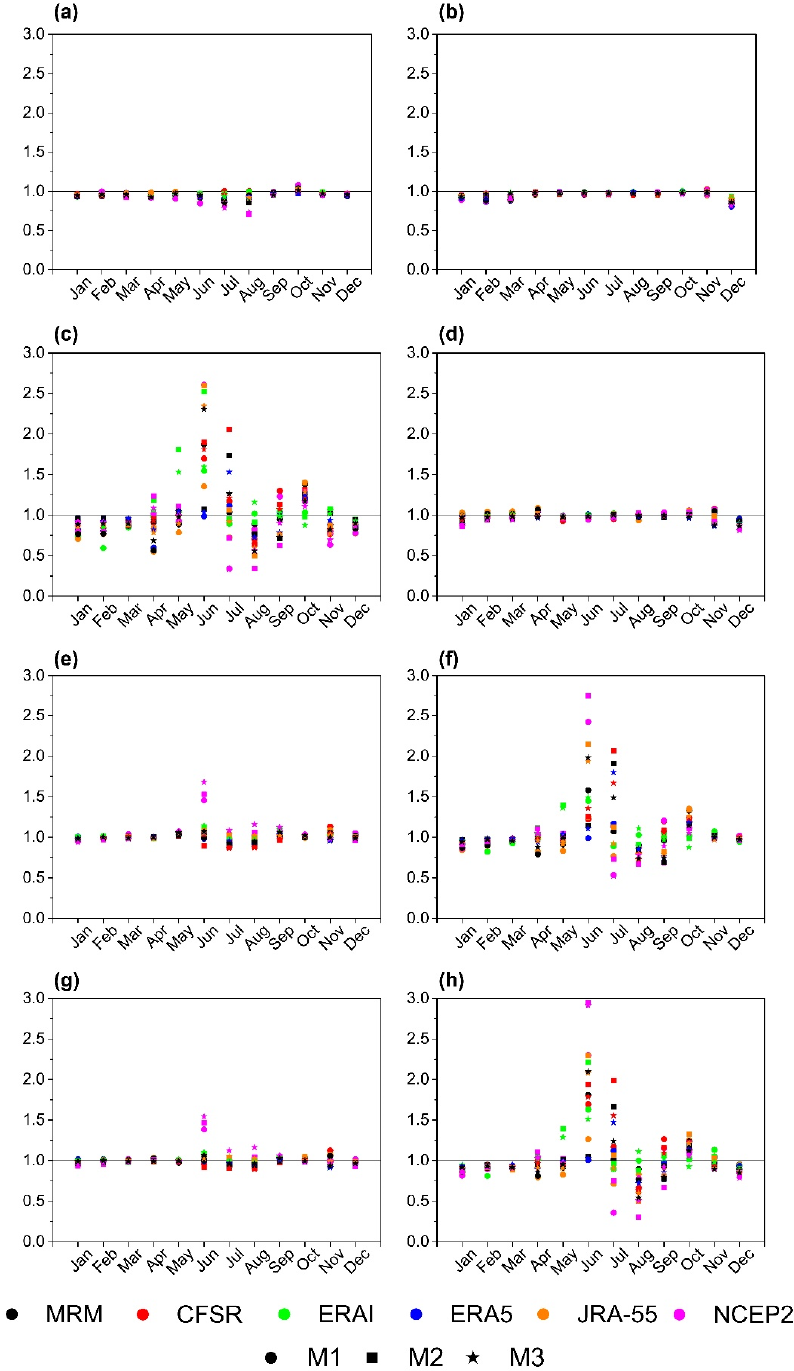
Figure 11. ( a ) Annual cycle of the standard deviation ratio between the uncorrected and corrected NH HCI derived from M1 (cycle), M2 (square), and M3 (pentagram) using the MRM (black), CFSR (red), ERA-Interim (green), ERA5 (blue), JRA-55 (orange), and NCEP2 (magenta) data sets from 1979–2018. ( b – h ) Same as ( a ) but for the SH HCI, NE, SE, CE, NH HCW, SH HCW, and TOT HCW,